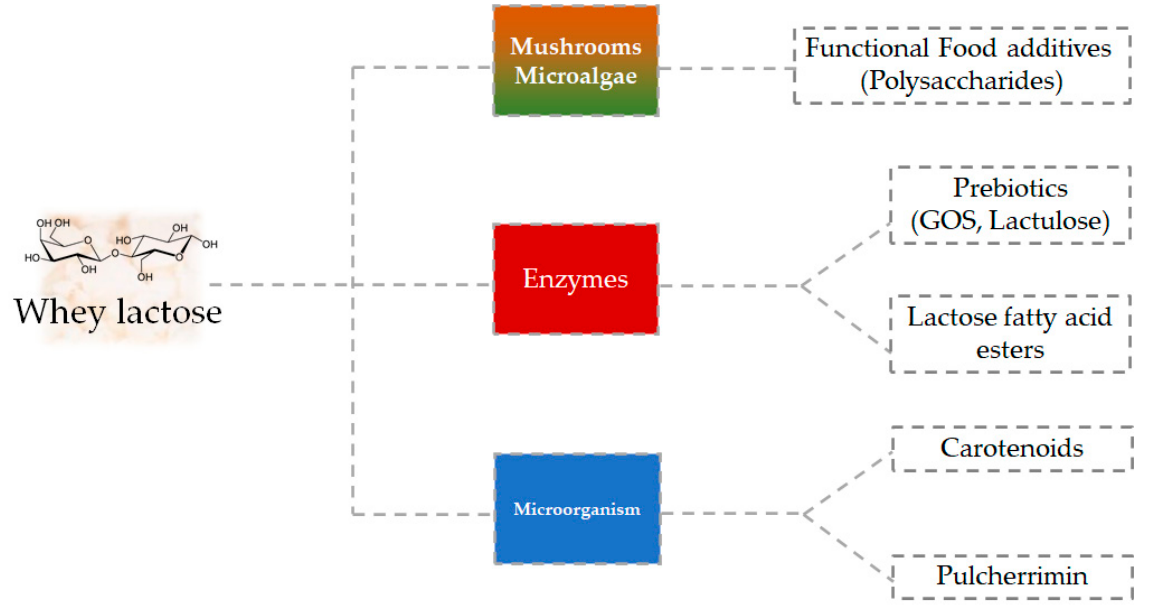
Figure 2. Innovative strategies for valorization of lactose from whey cheese. GOS: Galacto-oligosaccharides.